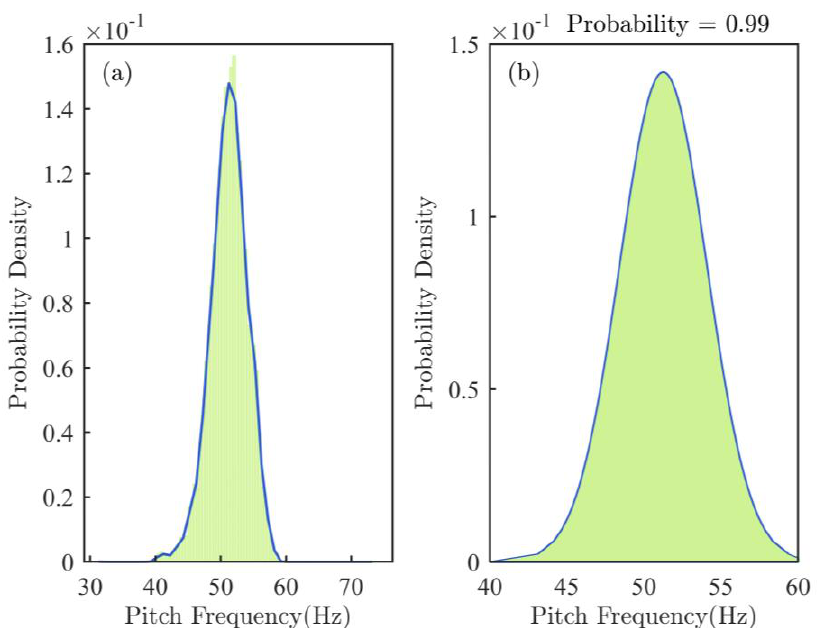
Figure 9. Probability density distribution of the flow turbulence pitch frequency 𝐹𝑓 𝑝𝑖𝑡𝑐ℎ : ( a ) The vertical axis values of the histogram (green part) indicate the probability of the sample falling in each frequency interval, and the blue curve is the probability distribution fitting curve; ( b ) the probability value (shaded green area) calculated using autonomous programming.